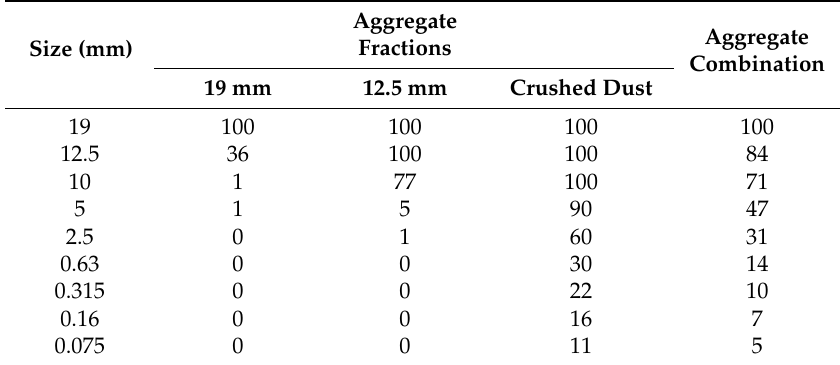
Table 1. Particle size distribution of aggregates